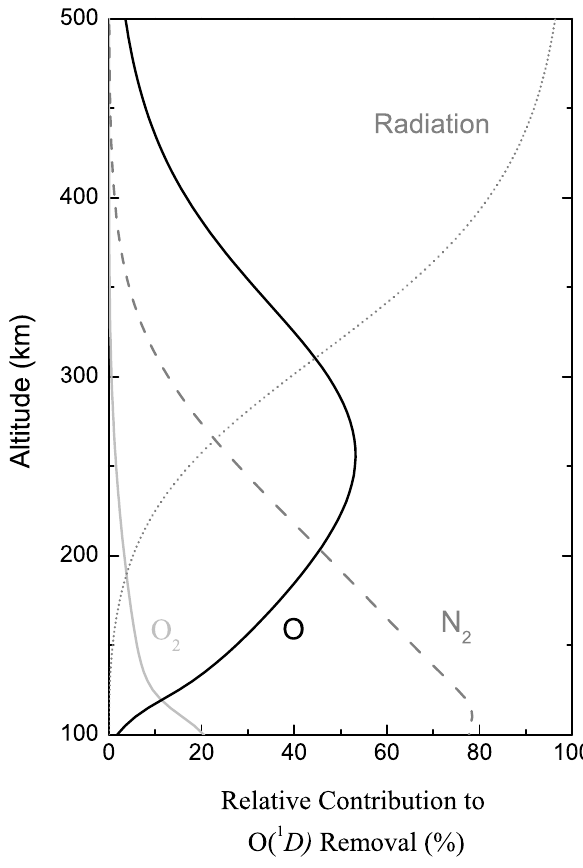
Fig. 1. Calculated relative contribution to O( 1 D) loss as a func- tion of altitude by O (solid black line), O 2 (solid grey line), N 2 (dashed grey line) and radiative decay (dotted grey line). These four processes are assumed to be the only pathways for O( 1 D) re- laxation. The atmospheric composition is based on the MSIS-E-90 model (Hedin,